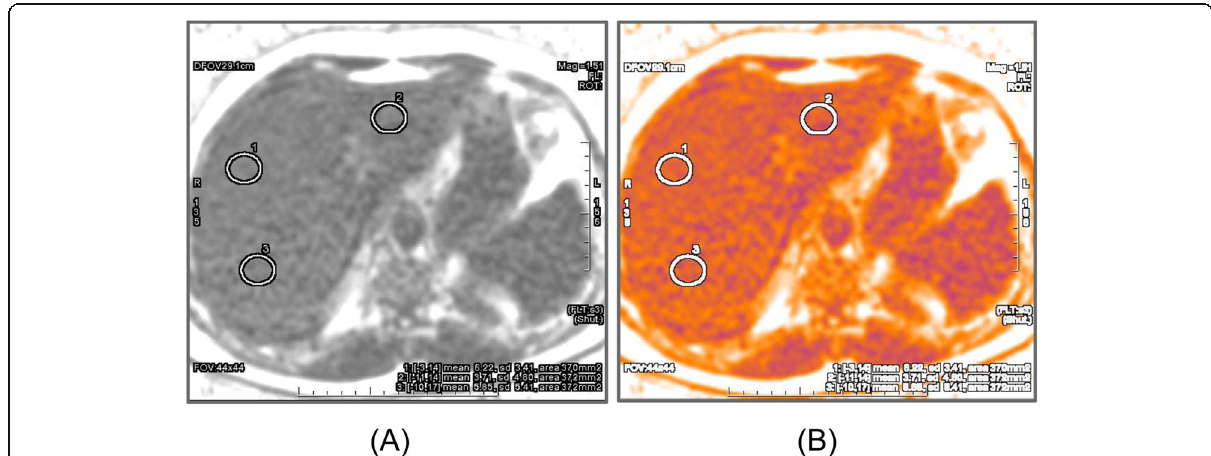
Fig. 1 a , b Representative example of ROI measurement on axial MR HFF map. Three approximately 3.4 – 5.4 mm 2 ROIs were drawn in the midplane of the liver